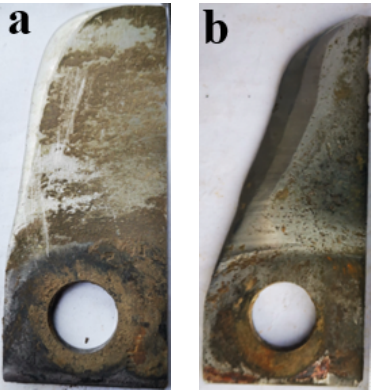
Figure 8. Macro morphologies of the two knives after 50 h of operation: ( a ) knife with laser cladding; ( b ) knife without laser cladding.